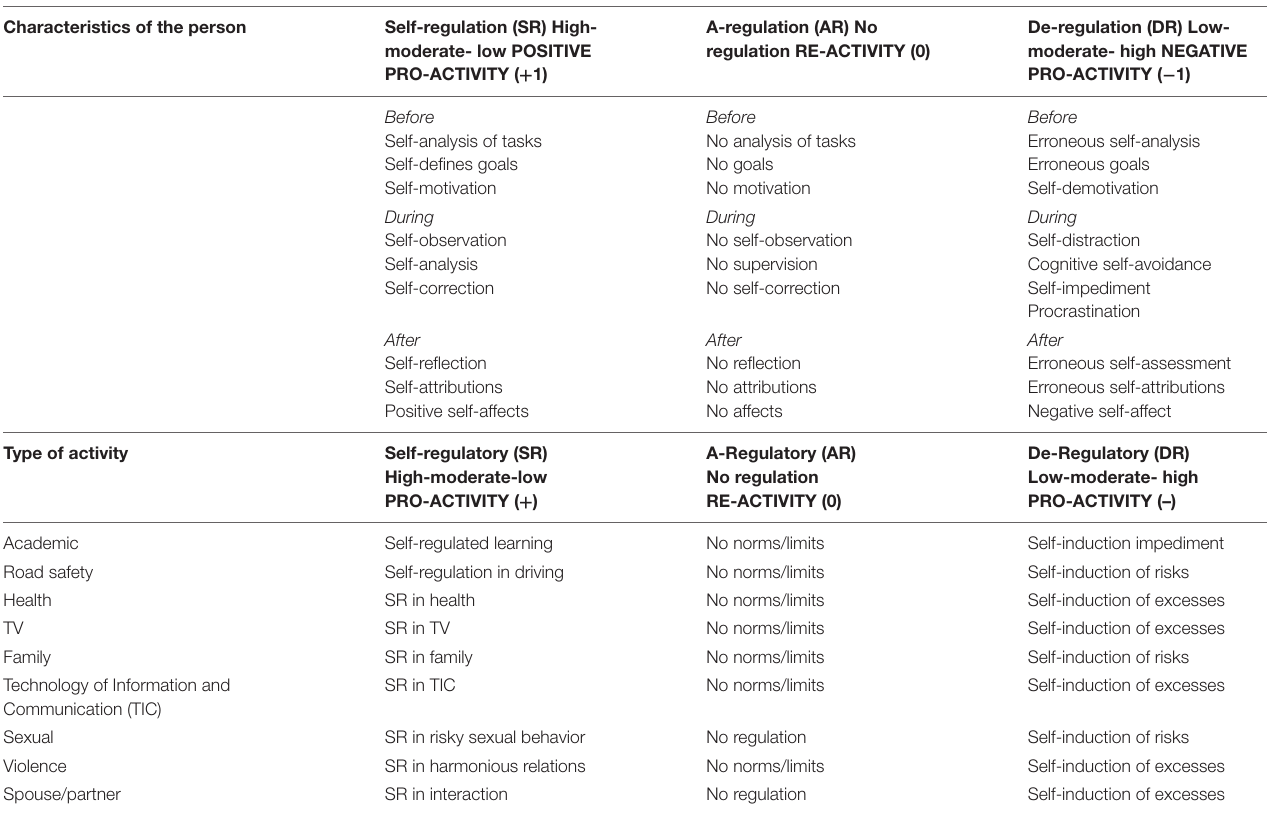
TABLE 1 | Conceptual continuum and typologies of each Self-Regulatory Behavior. Characteristics of the